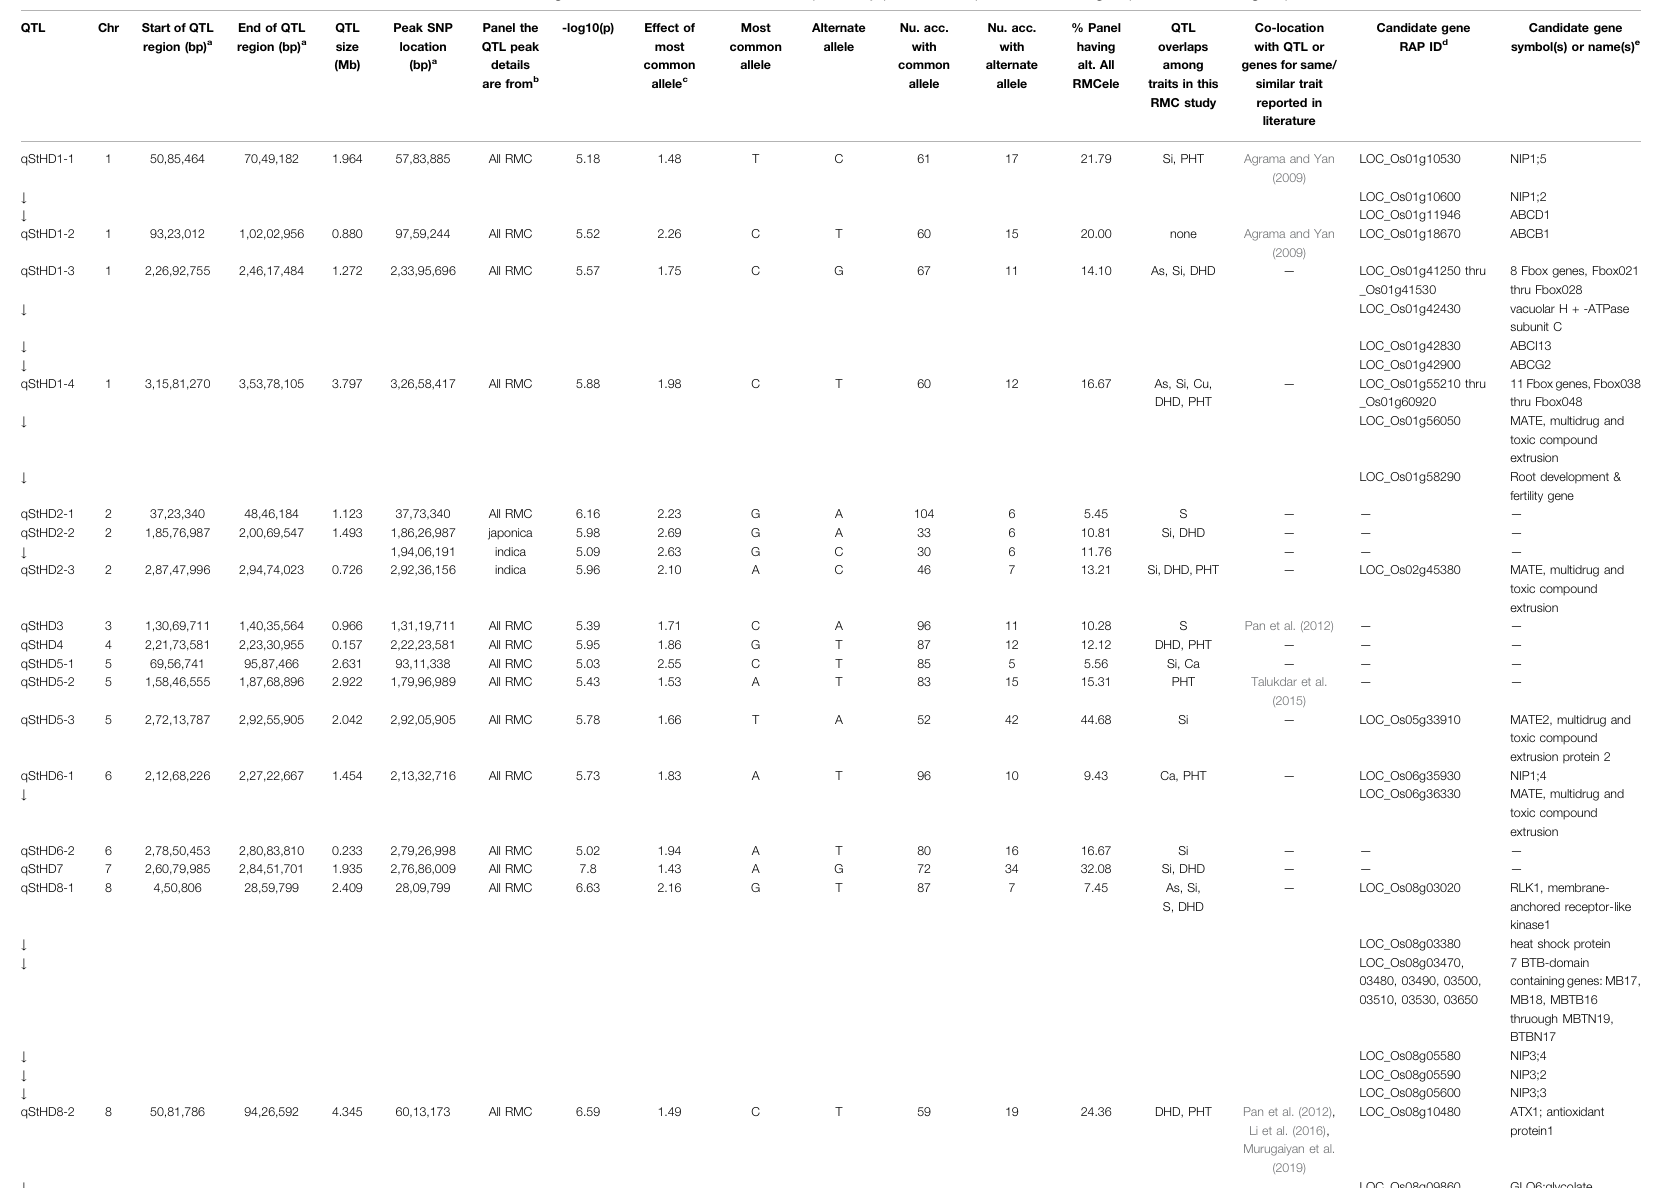
TABLE3| QTLassociatedbyGWAwithstraightheaddiseaseresponse(qStHD)intheRiceMinicorePanel(RMC)arrangedinchromosomalorder.OverlapswithQTLforothertraitswithinthisstudy,andcandidategenesare also noted. Panels for which QTL are listed include “ all RMC ” containing all RMC accessions, indica subspecies, japonica subspecies, IND subgroup, and AUS